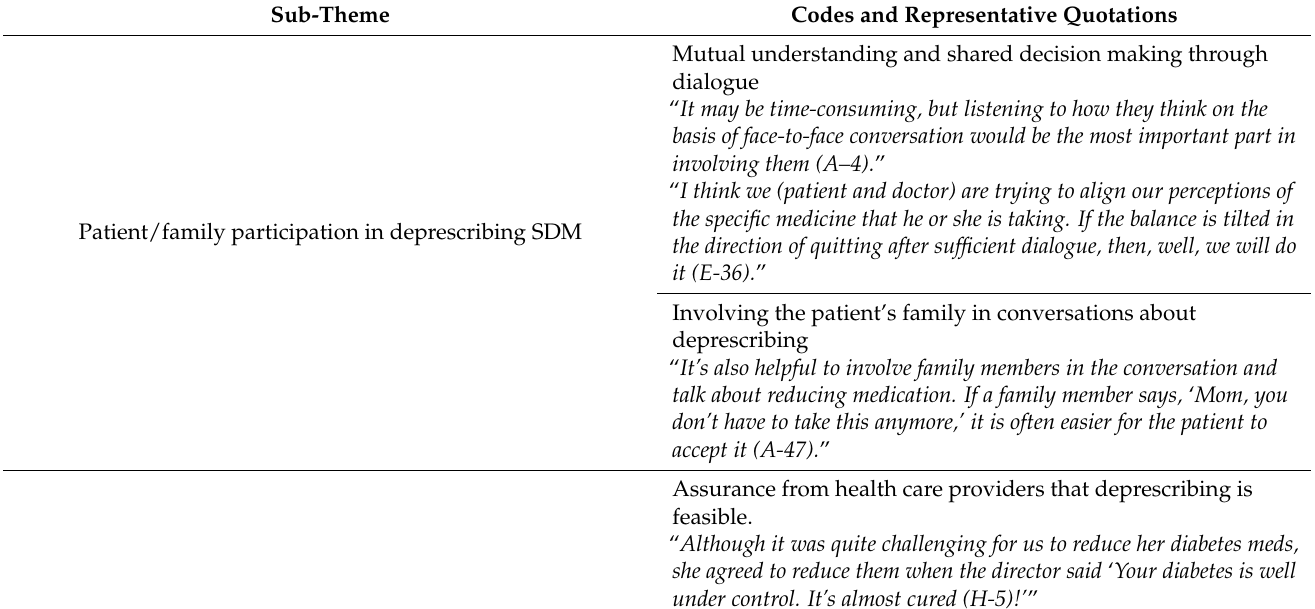
Table 3. Deprescribing strategies suggested by general practitioners and